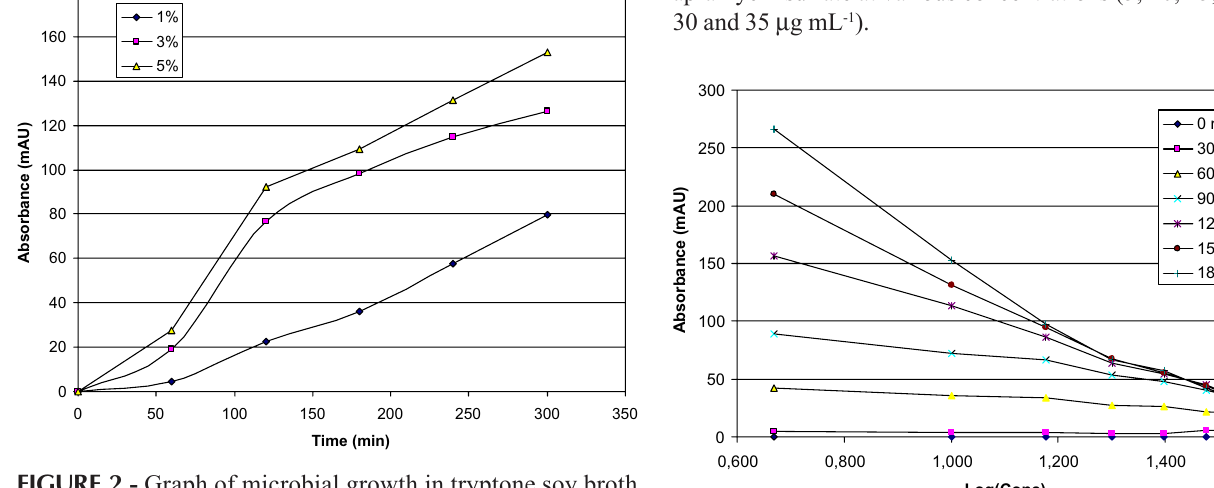
FIGURE 2 - Graph of microbial growth in tryptone soy broth inoculated with Escherichia coli (ATCC 8739) at 1%, 3% and 5% containing apramycin sulfate at 30 m g mL -1 .